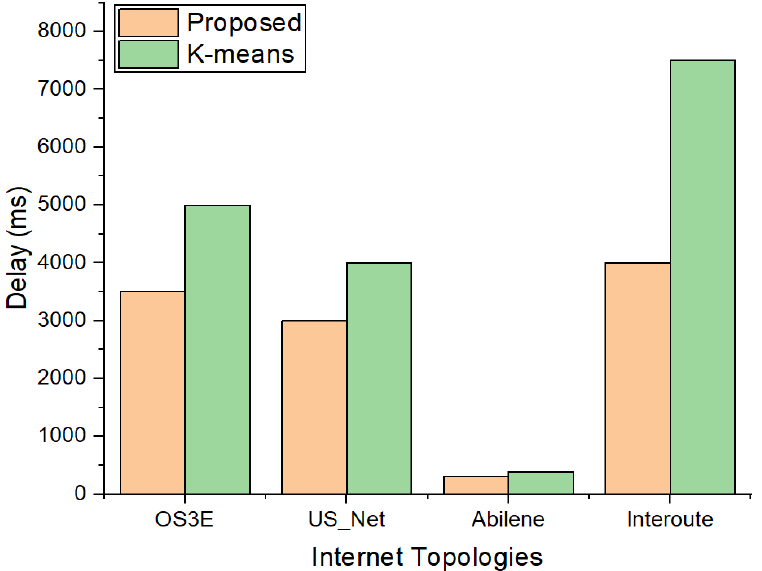
Figure 6. Comparison of E2E delay between proposed scheme and k-means with 7 clusters.